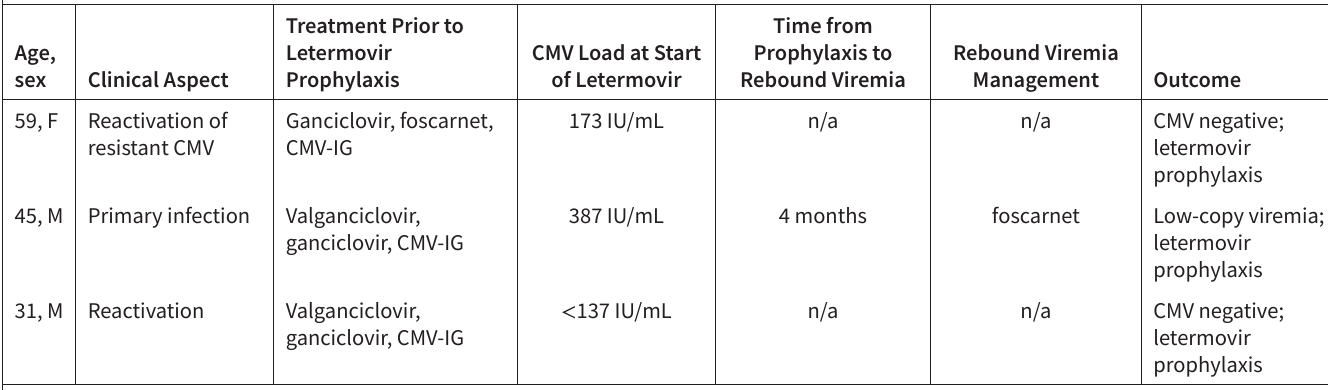
Table 1. Overview of the Cases with Respect to Letermovir Secondary Prophylaxis